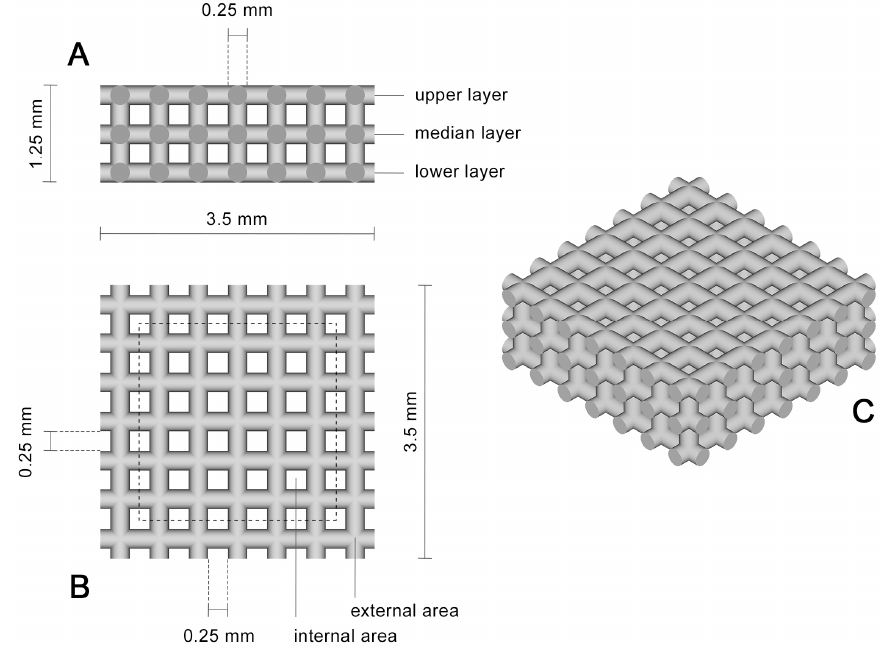
Figure 1. Schematic side view ( A ) top view ( B ) and 3D view of the scaffold geometry; ( C ) The dotted line marks the division of the implant into an external and internal area.